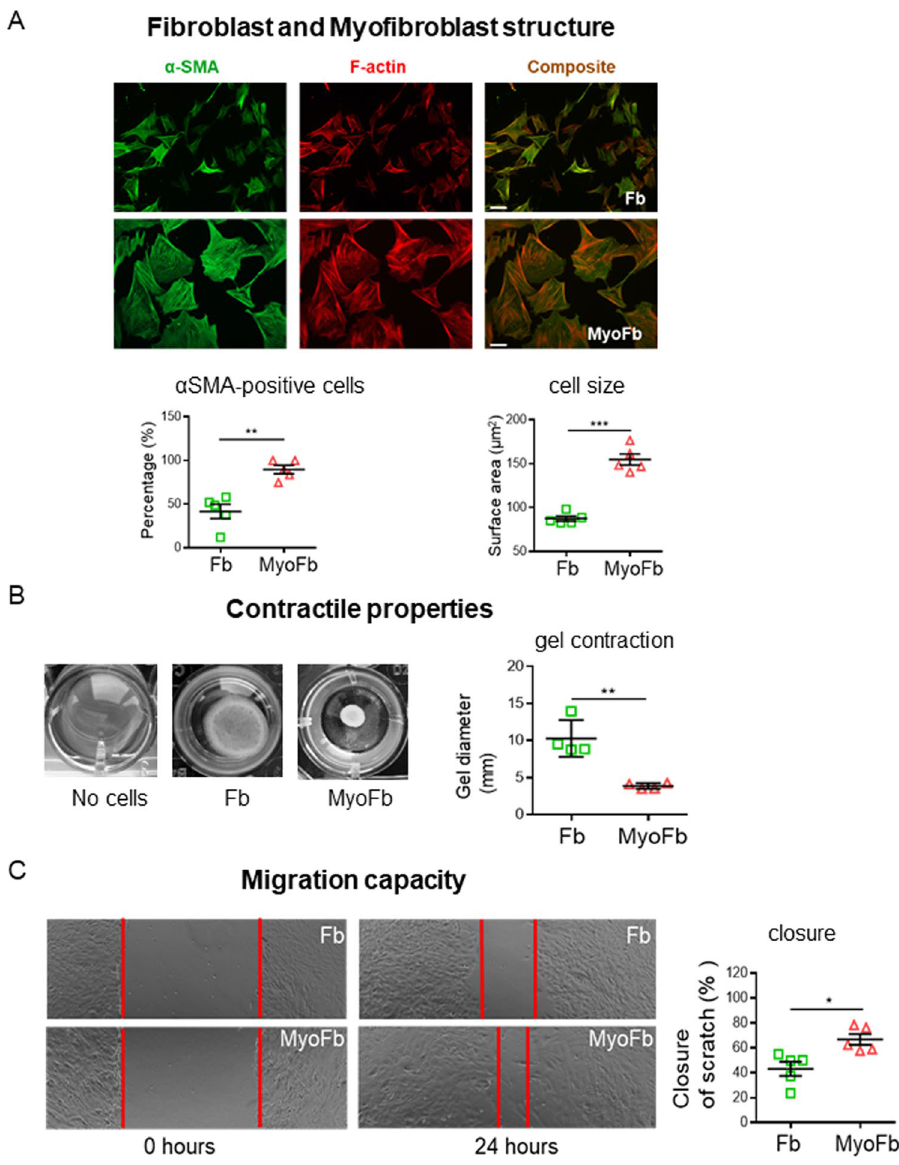
Figure 1. Fb phenotypes characterization. ( A ) Example of cultures of Fbs and MyoFbs with cells stained for F-actin and α -SMA. Quantification of cells positive for α -SMA, as percentage of all cells, and data of average cell size, measured in F-actin staining (N cultures = 5). (two-tailed Student t-test, ** p = 0.00978, *** p = 0.00012). ( B ) Analysis of the collagen gel contraction after 48 hours in culture. (N cultures = 4; two-tailed Student t-test, ** p = 0.00218). ( C ) Representative image of scratch at 0 hours and after 24 hours and analysis of cell migration of Fbs after 24 hours. (N cultures = 4; two-tailed Student t-test, * p =